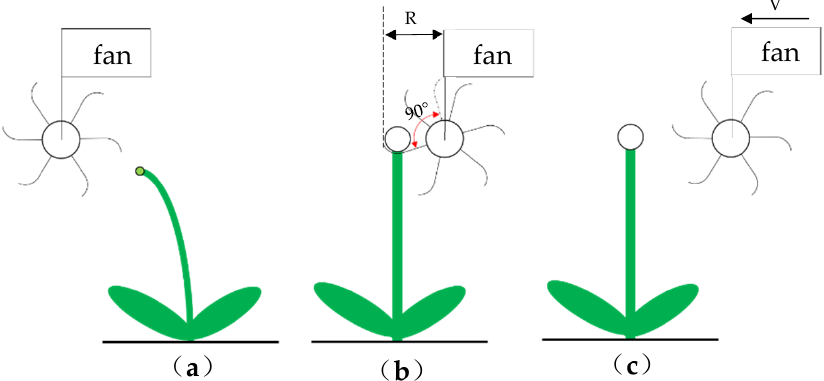
Figure 5. Schematic diagram of perturbation process. ( a ) After the perturbation process. ( b ) During disturbing the process. ( c ) Before the perturbation process. Screen, V and R, represent the forward speed of the harvester (m · s − 1 ) and radius of rotation of the disturbing roller (m).